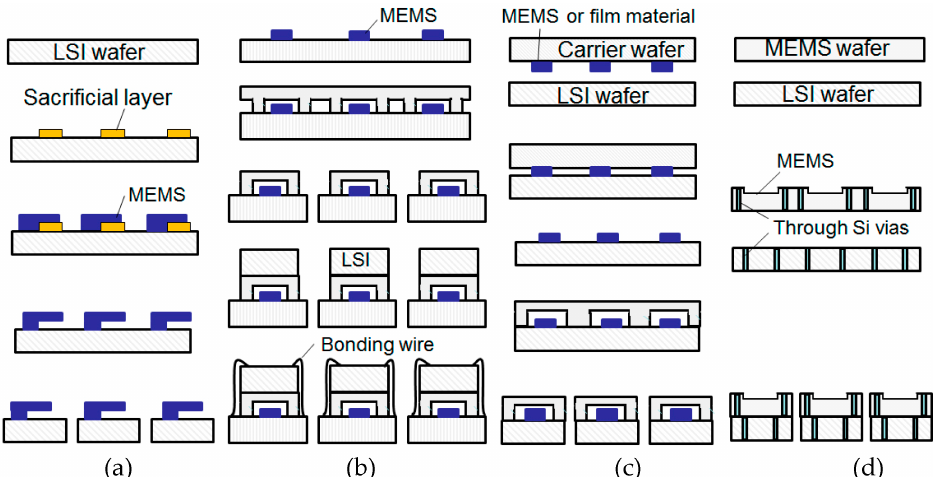
Figure 1. Heterogeneous integration processes; ( a ) surface micromachining; ( b ) assembly of packaged MEMS and LSI; ( c ) wafer-level transfer of MEMS to LSI (combined with a wafer level packaging); and ( d ) stacked integration using through Si vias.